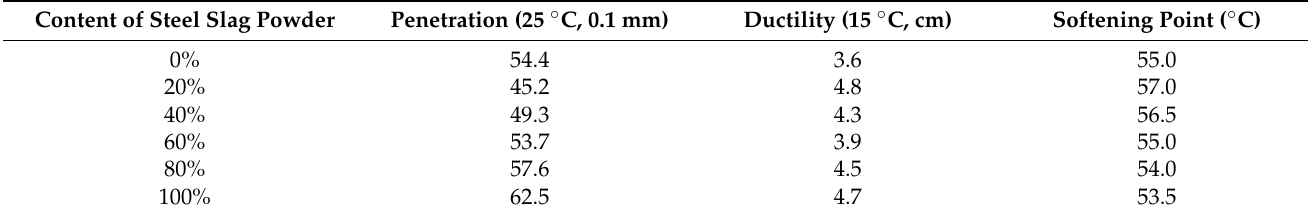
Table 5. Physical results of P-AM.